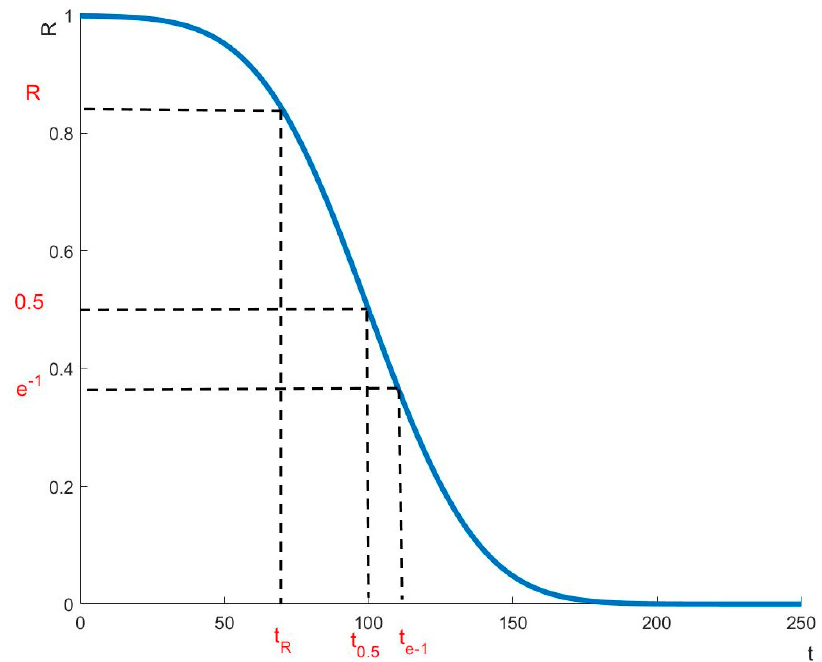
Figure 2 . The reliability curve. Figure 2. The reliability